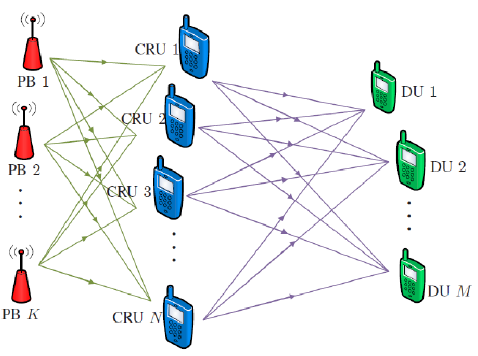
Figure 1. System model. PB, power beacon; CRU, cooperative relay user; DU, destination